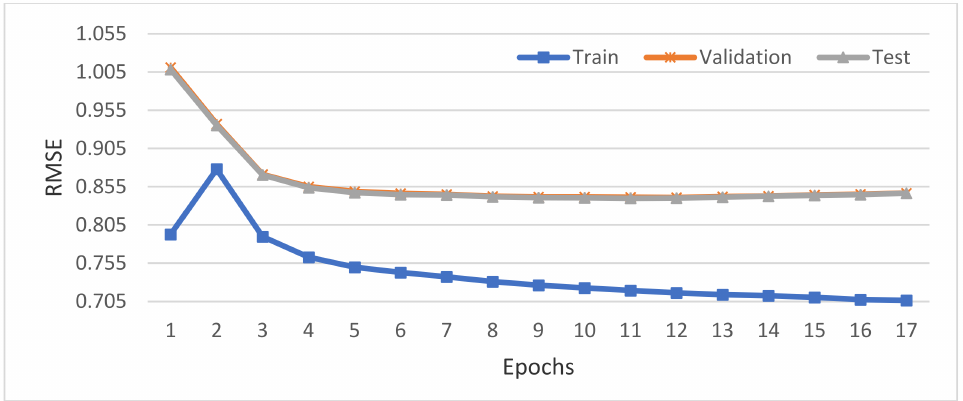
Figure 5. Changes of the RMSE of the training set, cross-validation set, and test set under ML-1m with the number of